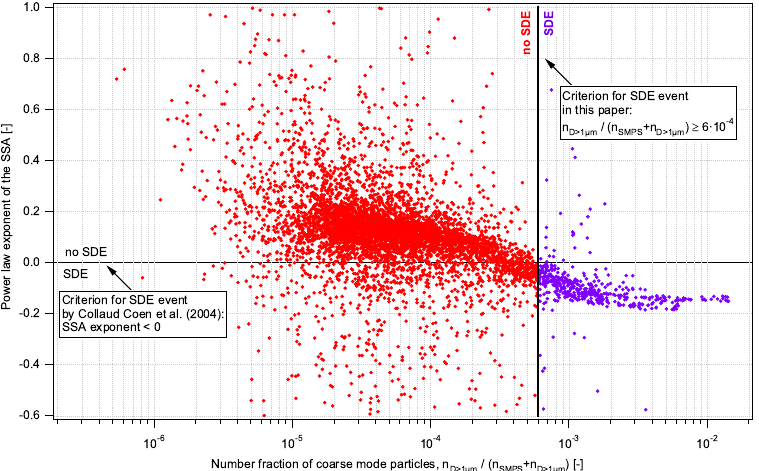
10 -2 Number fraction of coarse mode particles, n D>1(cid:181)m / (n SMPS +n D>1(cid:181)m ) [-] Fig. B1. 4-h average values of the power law exponent of the single scattering albedo versus the number fraction of coarse mode